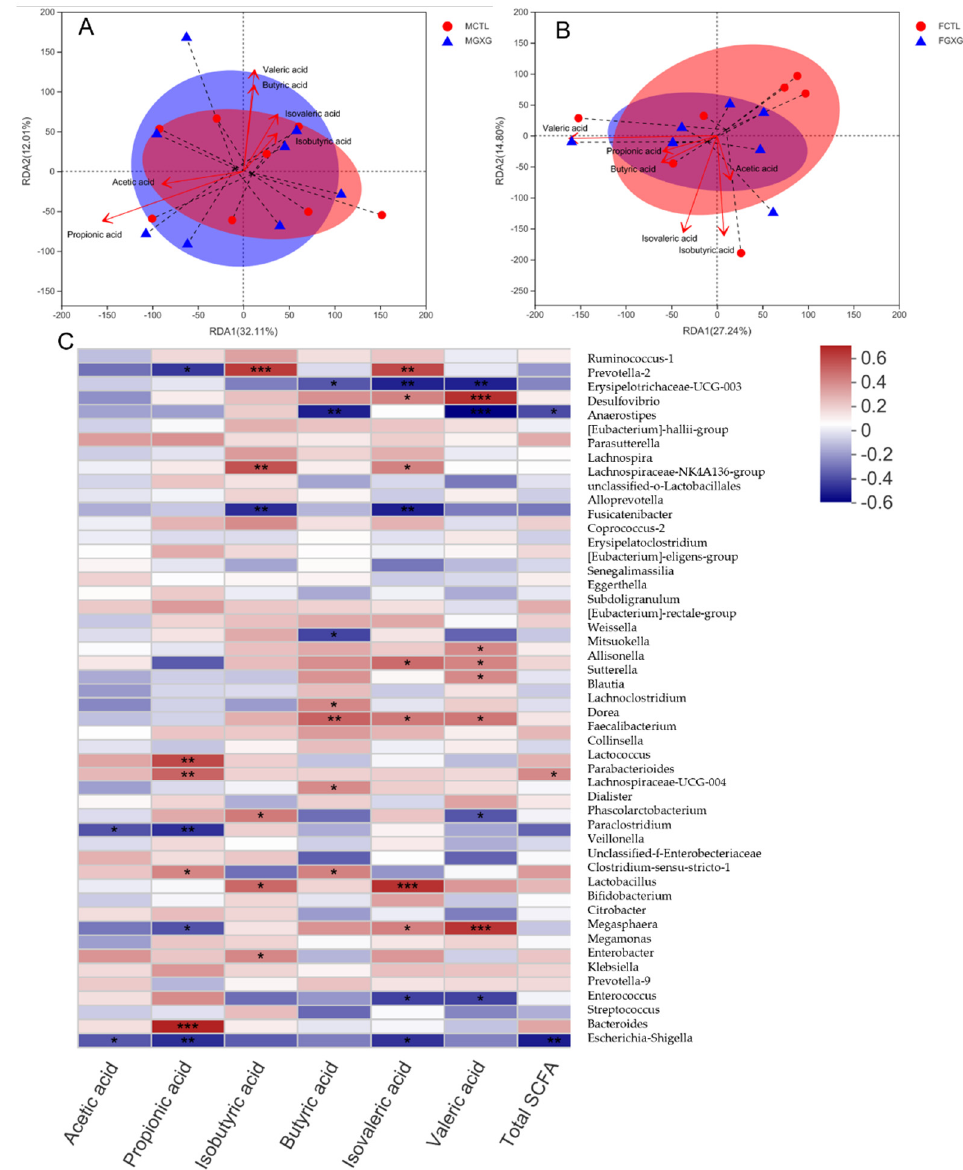
Figure 6. RDA analysis between SCFA and DOP of ( A ) men and ( B ) women. ( C ) Correlation between SCFA and microbiota. * p <0.05. ** p <0.01. *** p< 0.005.